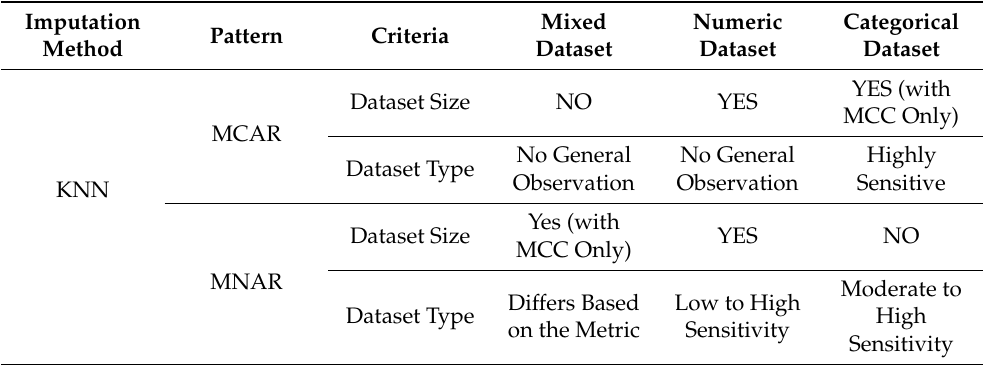
Figure 5. Performance of the five classifiers on the six datasets with different ratios of MNAR MVs imputed using mean/mode. Table 3. Summary of the five classifiers’ performance with respect to the properties of the datasets and the two imputation